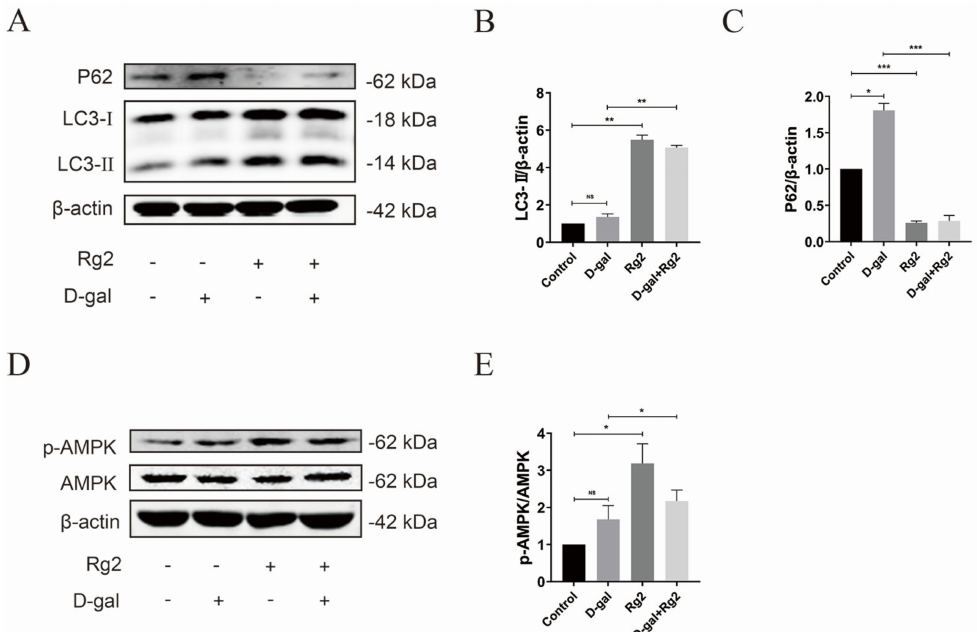
Figure 7. Ginsenoside Rg2 induced autophagy in pMSCs via the AMPK signaling pathway. After pre-incubation with 20 g/L of D–gal for 24 h, pMSCs were treated with 100 µ M of Rg2 in the presence/absence of D–gal for another 24 h. ( A ) Western blot analysis with anti–P62 and anti–LC3 antibodies in pMSCs after different treatments. ( B ) Quantification of LC3 expression levels in ( A ). ( C ) Quantification of P62 expression levels in ( A ). ( D ) Western blot analysis with anti–p–AMPK